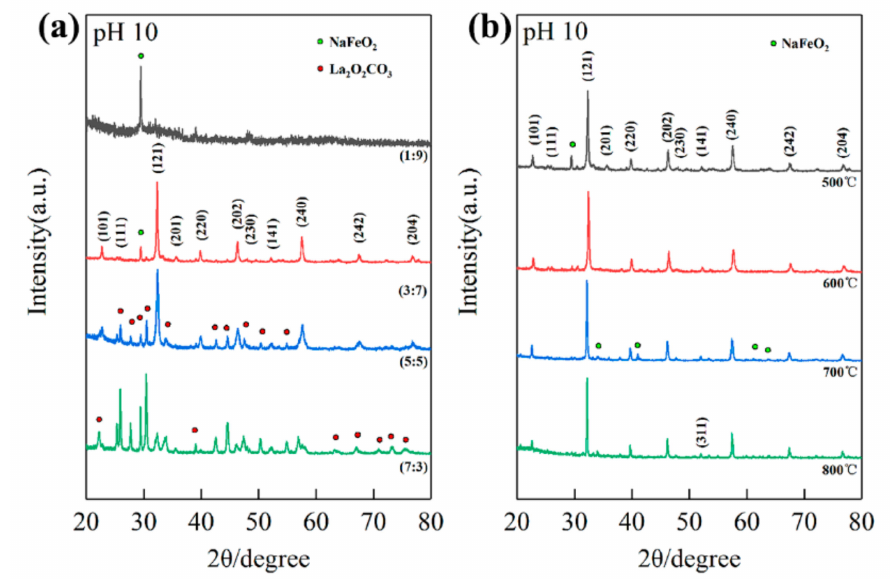
Figure 2. The XRD patterns of different La/Fe ratios after calcination at 500 ◦ C ( a ) and the XRD patterns of La/Fe 3:7 after calcination at different temperatures ( b